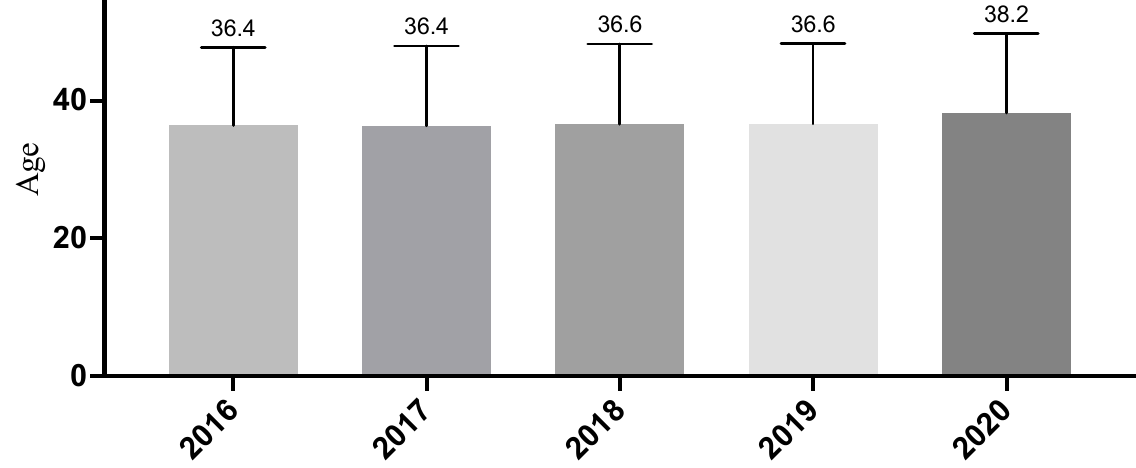
Figure A2. Sex distribution depending on the year of measurement. The age of the respondents ranged between 14 and 90 years (M = 36.59; SD = 11.56). A slight trend was observed indicating the mean age of the examined patients slightly increased with each year of measurement (see Figure A3). Clarification: patients can change age categories if their change in age necessitates this; this is not to be misinterpreted for a tautological restatement of the patients aging with time.